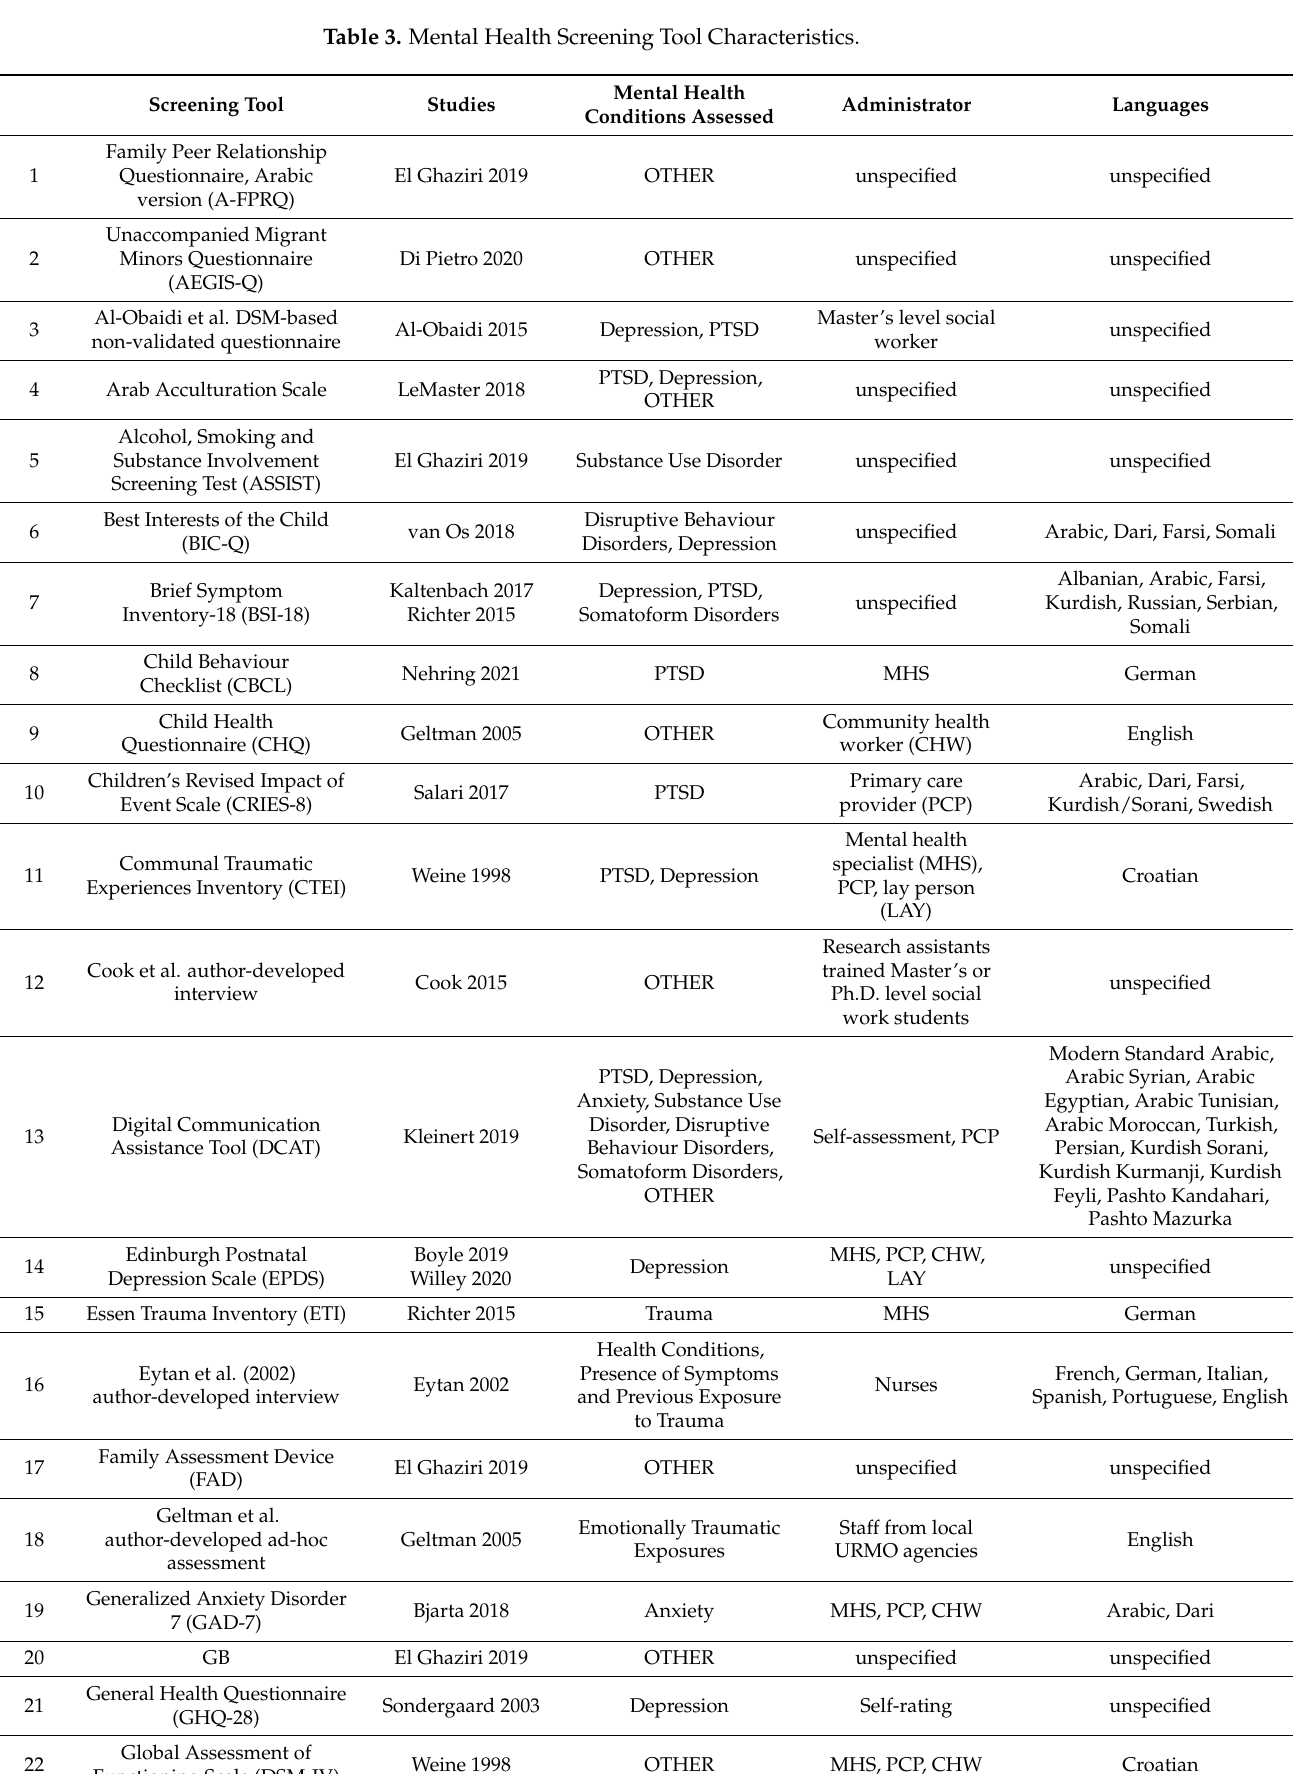
Table 3. Mental Health Screening Tool